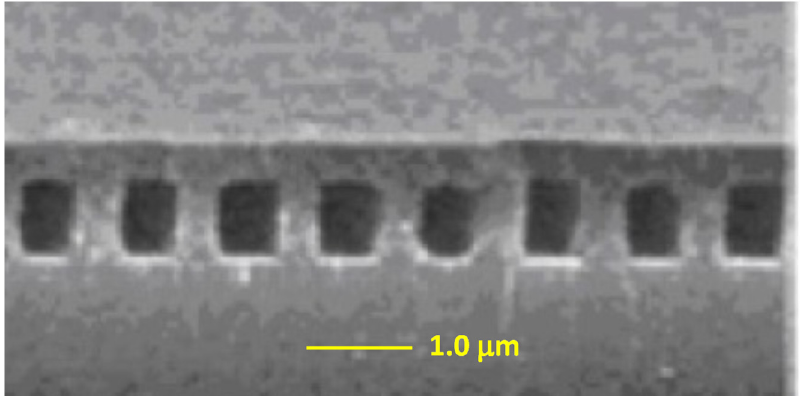
Figure A2. Cross-sectional SEM of nanochannels after spin deposition of silica nanoparticles and high-temperature calcination to remove the photoresist. The yellow line indicates 1.0 μ m length.